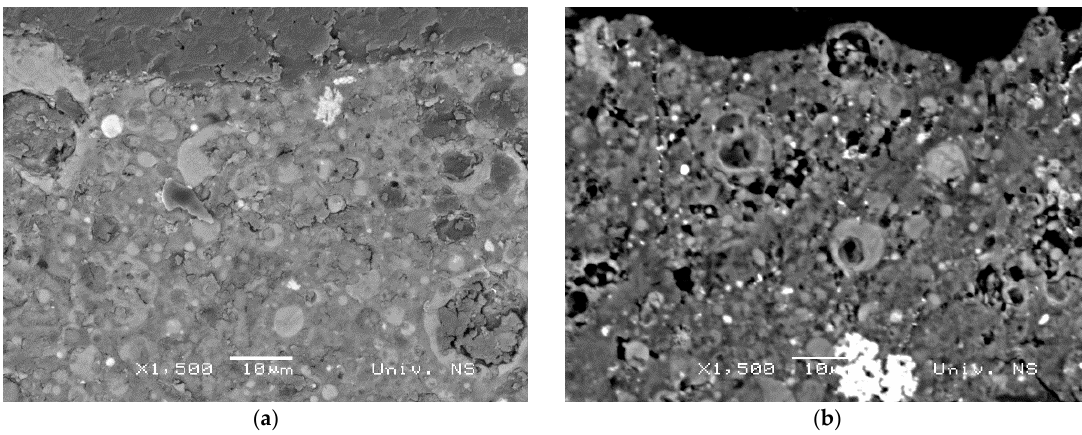
Figure 5. BSE micrograph of samples ( a ) GP 28 and ( b ) VC 28.